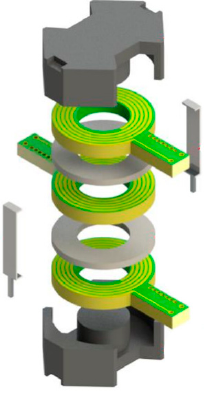
Figure 6. Deconstructed view along the ferrite core, planar winding circuit board, spacers, and clamps.